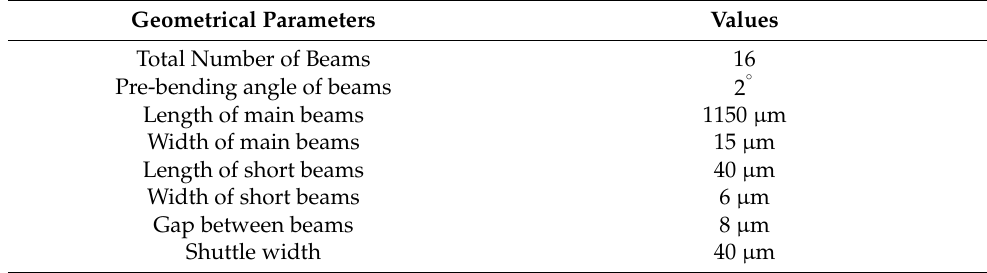
Figure 9. ( a ) Boundary conditions of the static structural analysis; ( b ) directional displace- ment along the vertical direction at the shuttle of the microgripper when a full range input Table 2. Geometrical parameters of the thermal actuator. displacement is applied.